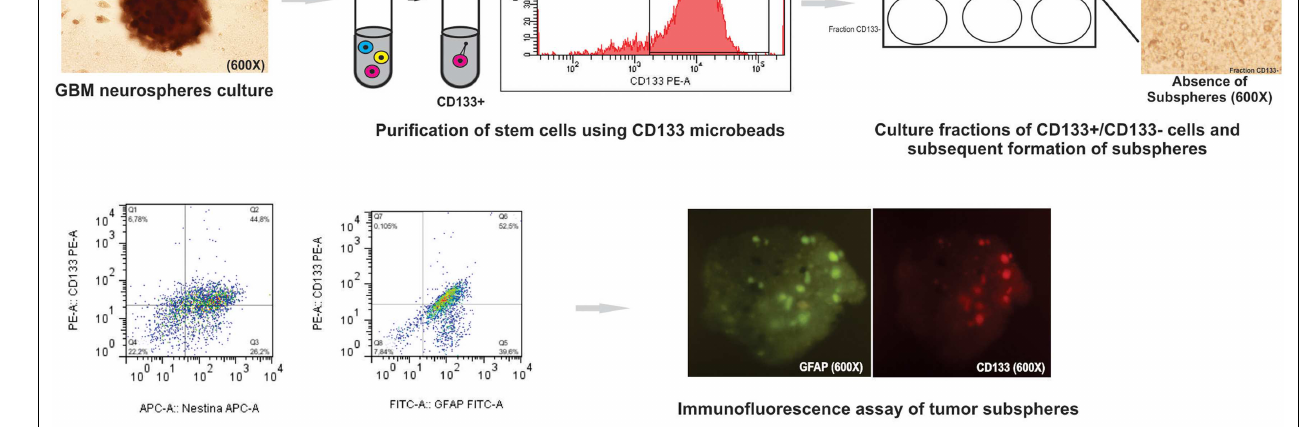
purification of the cell population known for initiate the tumor (CD133 + cell) by MACS and evaluation by flow cytometry; (v) purification of stem cells using CD133 microbeads by; (vi) formation of subspheres in CD133 + cells in neurospheres derived from glioblastoma primary culture; (vii) study of the expression level of GFAP, CD133, Nestin, Nanog, CD34, and Sox2 markers on tumor subspheres by flow cytometry and immunofluorescence